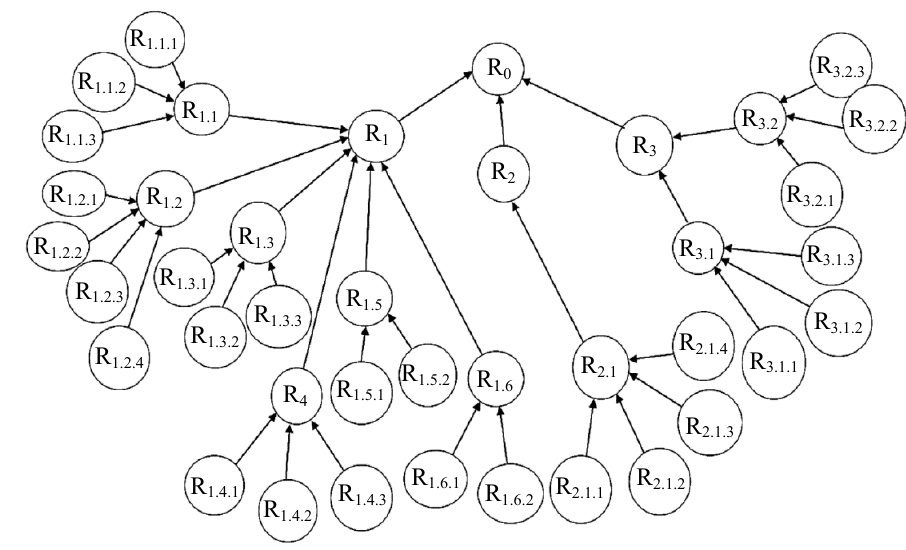
Fig. 3. Direct graph H of performance indicators of the quality management system of a food